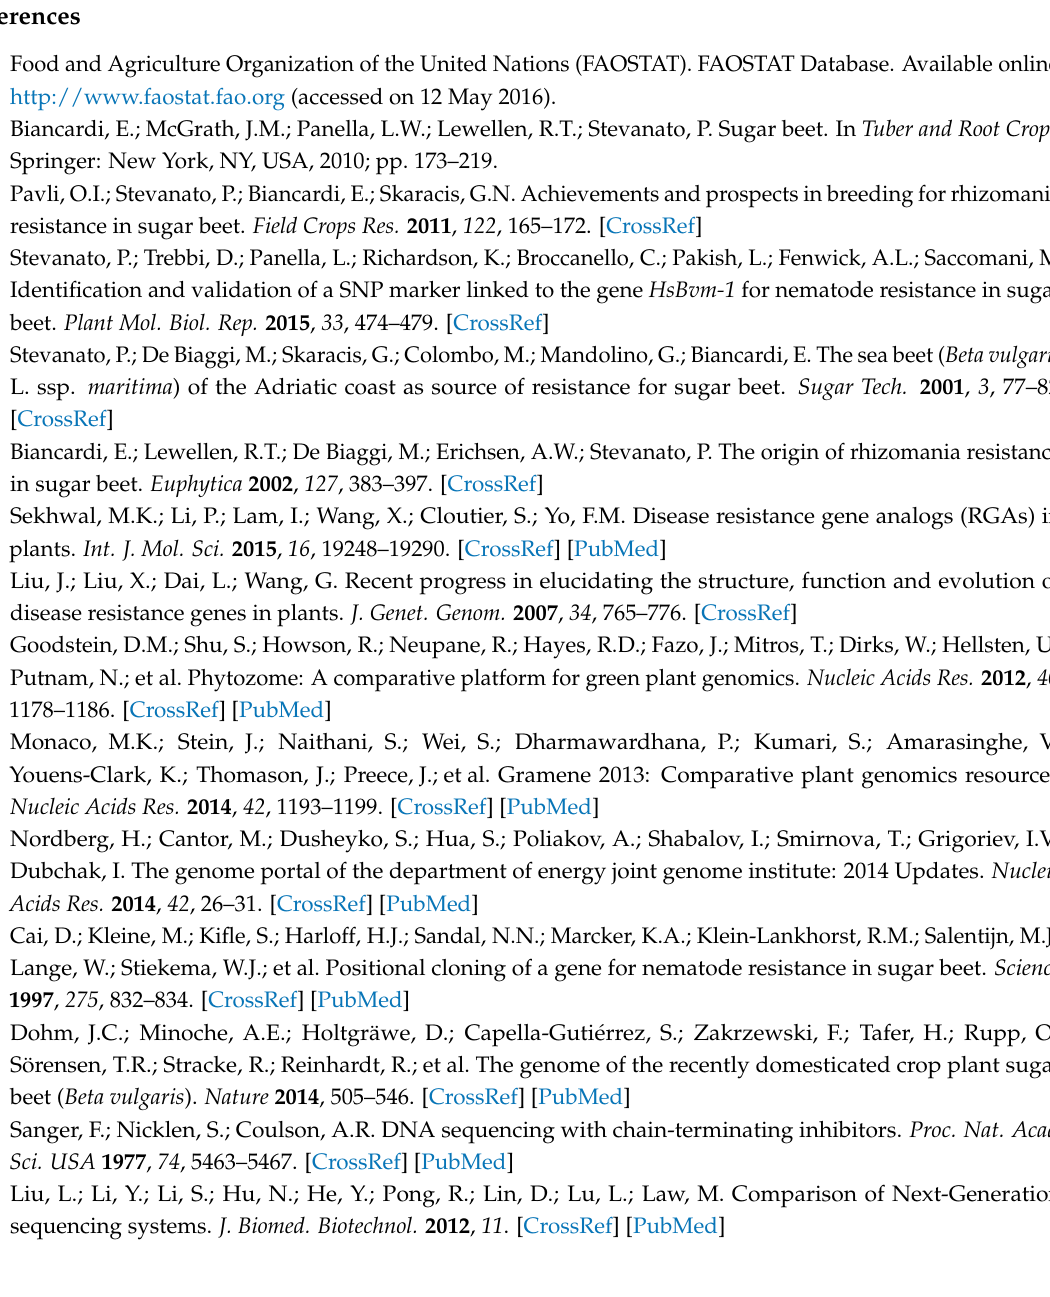
Figure S1: Sequence alignment of the Bv8_184910_pkon gene in wild and cultivated